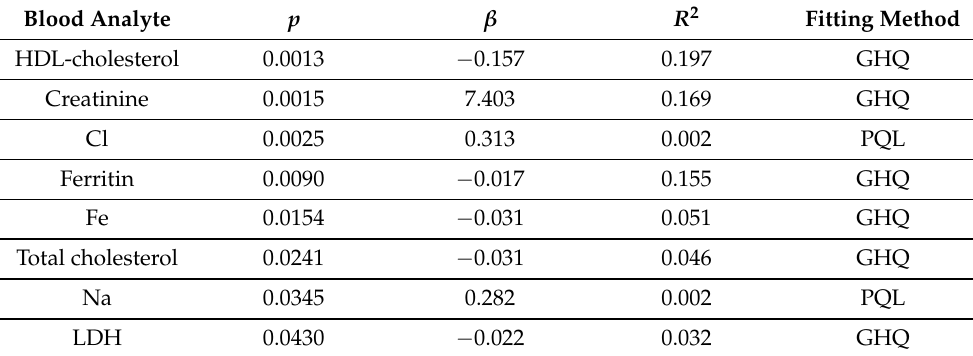
Table 2. Results of the statistical evaluation. “ p ” column contains, for each analyte, the result of the Wald test in terms of p -value. The “ β ” column shows the slope of the corresponding model. The “ R 2 ” column reports the CDR variability explained by the only model’s fixed effect, and the last column provides the fitting method for each analyte model.